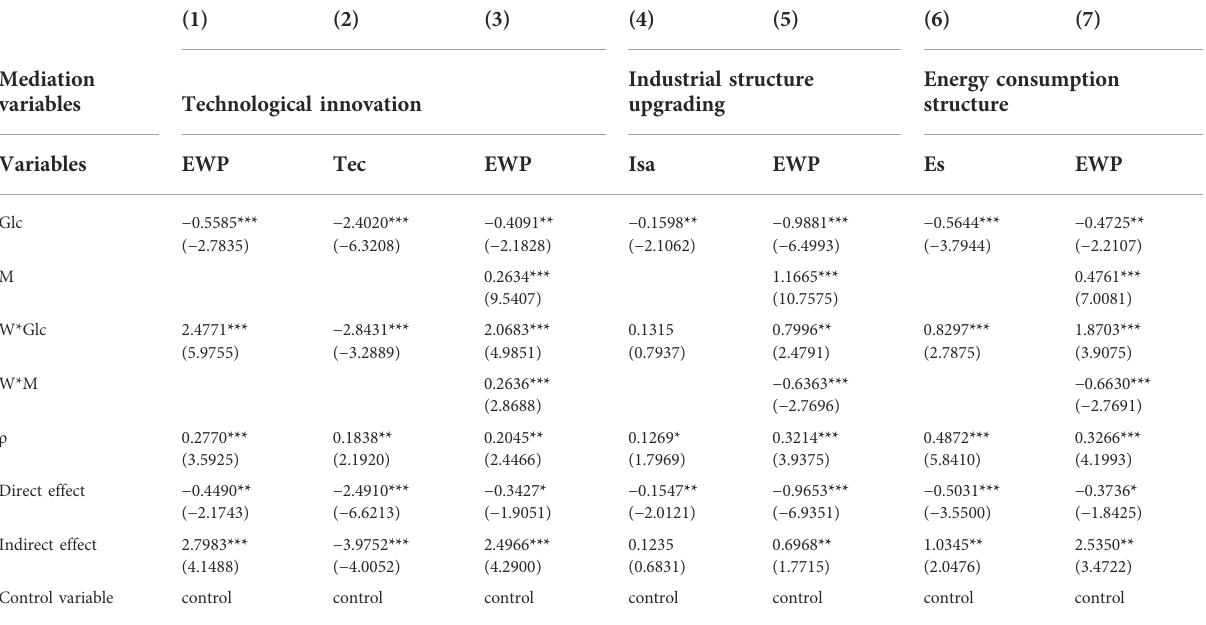
TABLE 9 The results of robustness test (replacement of variable measurement